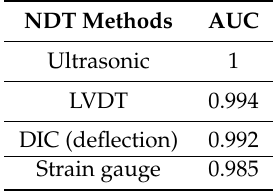
Figure 21. ROC curves for all the features in RC beam. Table 2. Overall results for different NDT